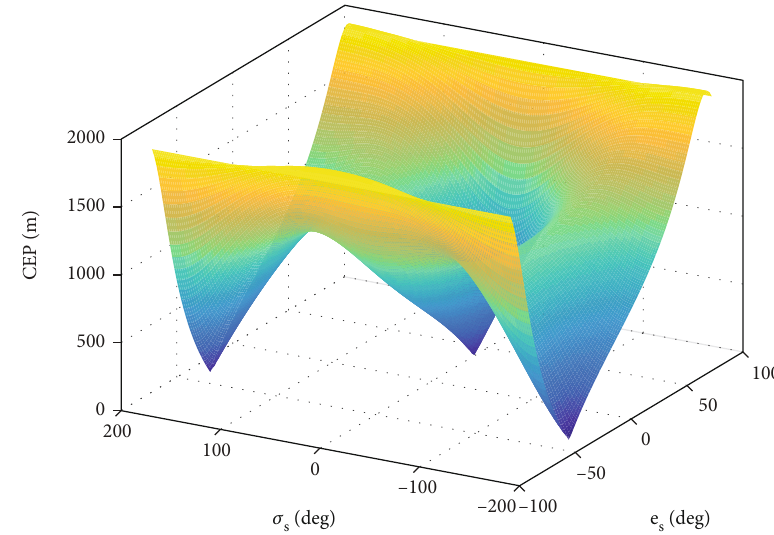
Figure 6: Composite guidance CEP variation diagram for 6000km.